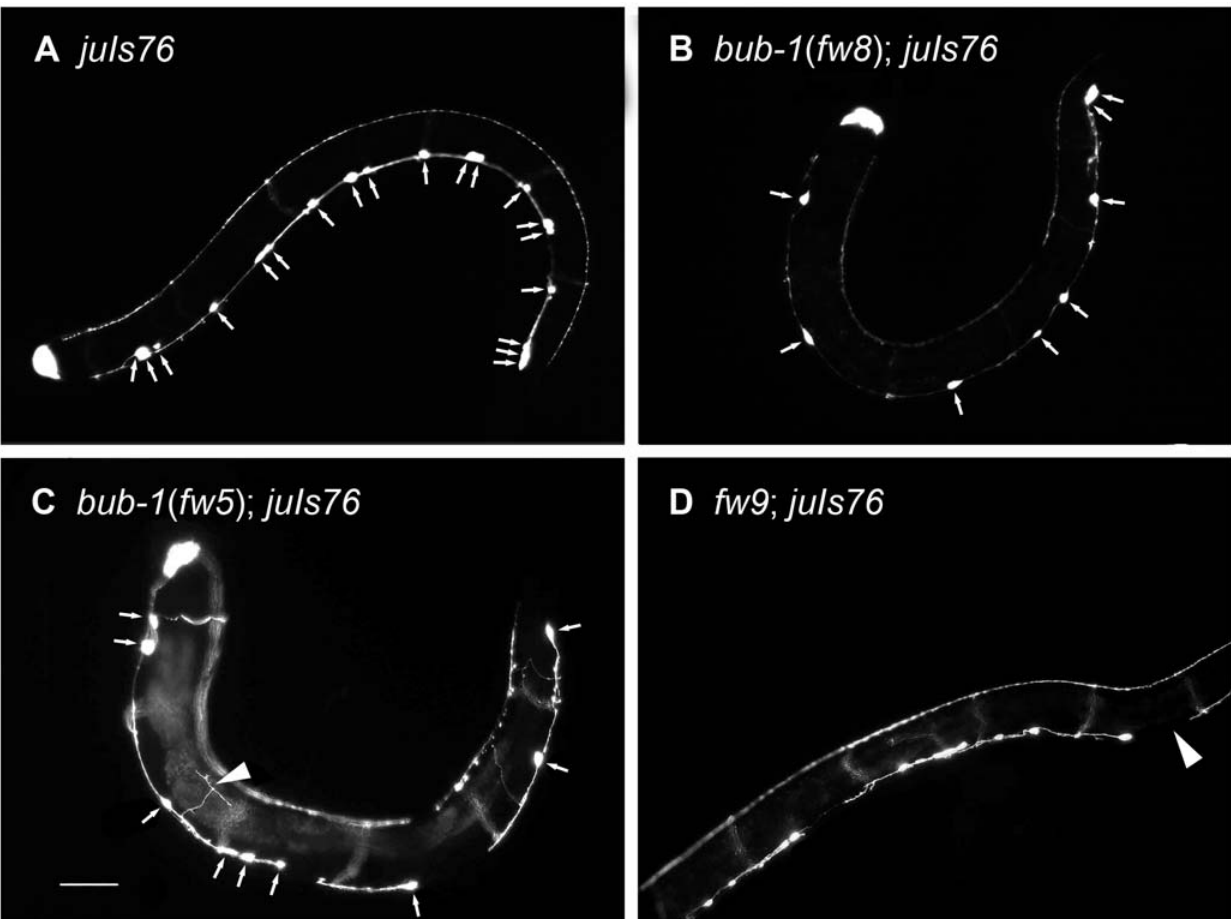
Figure 1. D-type Neuron and Axon Defects of Stu Mutants. (A) Wild-type animal ( juIs76 ) has normal ventral cord D-type neurons. (B) bub- 1 ( fw8 ) (C) bub-1 ( fw5 ) (D) fw9 . Arrows show D-type neurons of the ventral nerve cord. In the fw5, fw8 , and fw9 mutants, the numbers of D-type neurons were decreased when compared to the wild-type animal. The arrowhead shows axon guidance defects in the Stu mutants. Anterior is to the left and ventral is down. The scale bar represents 50 m m. doi:10.1371/journal.pone.0005912.g001 Table 2. Summary of the D-Type Motor Neuron and Axon Phenotypes of Stu Mutants.